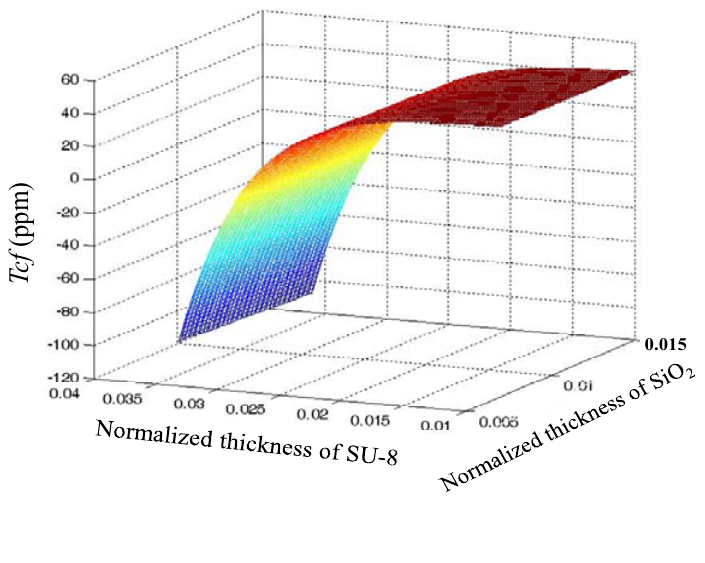
Figure 4. Calculated Tcf versus normalized layer